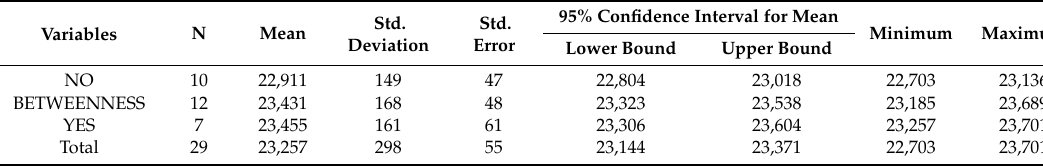
Table 12. One-way descriptive statistics (Y33).